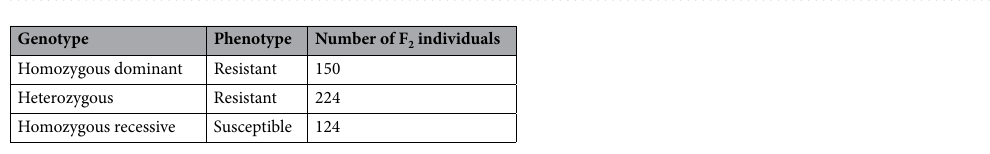
Table 3. Genotype of 498 F 2 individuals identified by CAPS2430